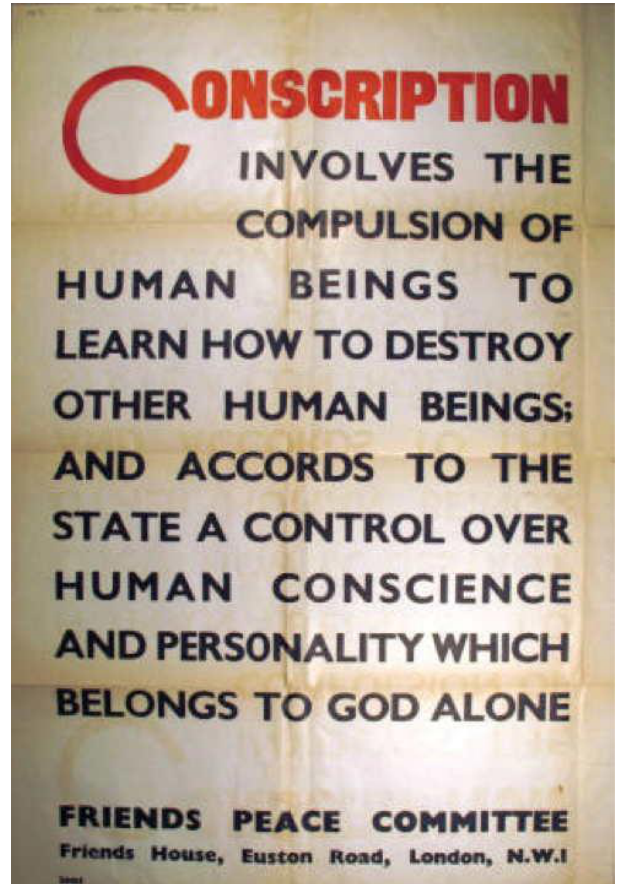
FIGURE 4: SYDNEY DORMAN OFFERS AN ANALYSIS OF THIS POSTER, “CHALLENG[ING] ‘TOTAL WAR’ WITH ‘TOTAL